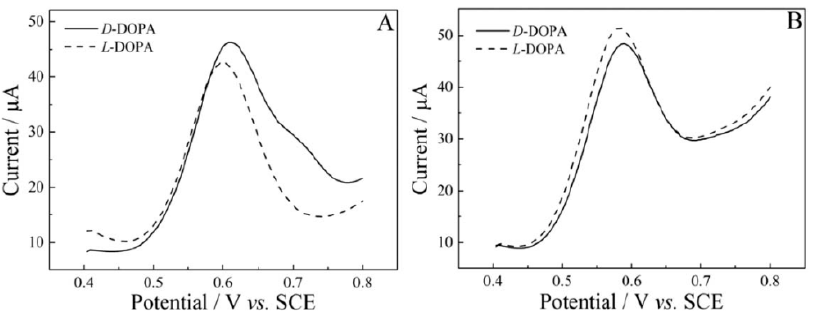
Figure 3. DPVs of with poly 7- R -GCE ( A ) and poly 7- S -GCE ( B ) modified electrodes in 0.25 M H 2 SO 4 containing 0.5 mM D -DOPA (solid line) or L -DOPA (dashed line. Reprinted with permission from reference [51]. Copyright 2015 Wiley.